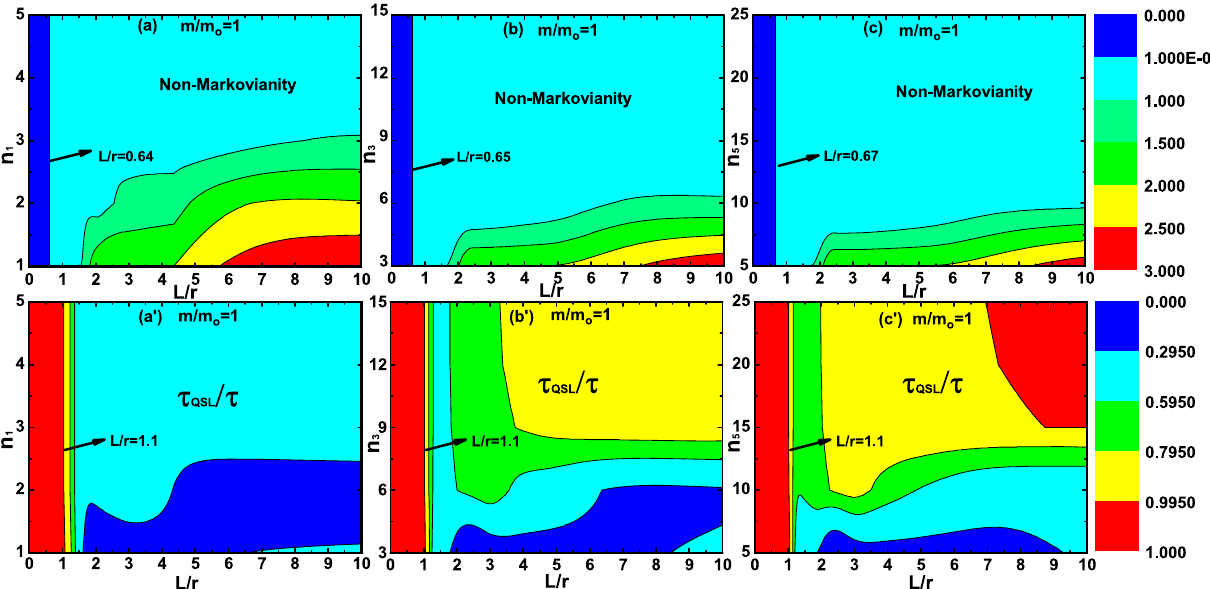
Fig. 2 For the two dimensional singular ray case ( x = 1, x = 3 and x = 5), and the actual evolution time τ = 0 . 4s, r =250 µ m and m = m o =10 − 13 kg. a – c Non-Markovianity N (ϕ) of the dynamics pro- cessofthesystemparticle m o asafunctionof L / r andthenumberofthe